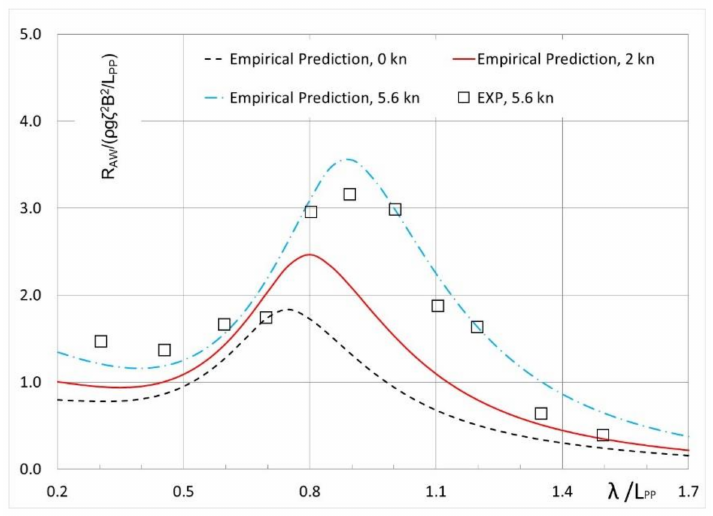
Figure 1. Added resistance of the VLCC design at low speeds in regular head waves at scantling draft, T = 22